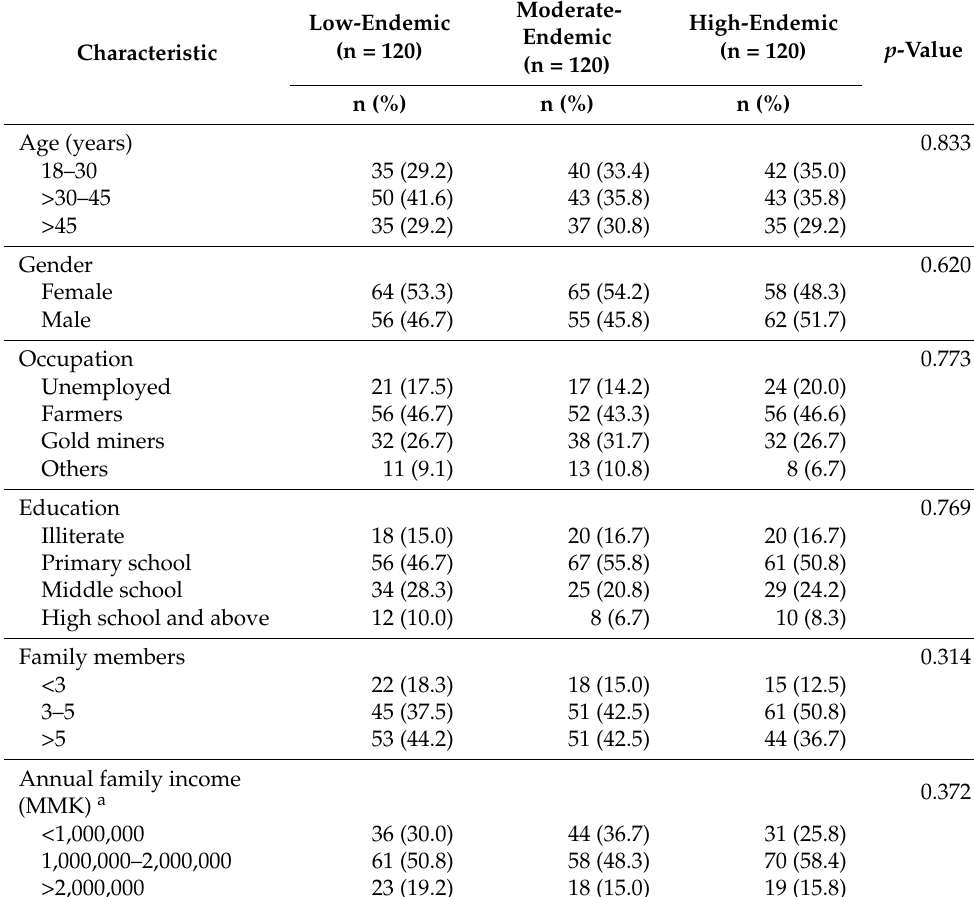
Table 1. General characteristics of respondents in each malaria-endemic